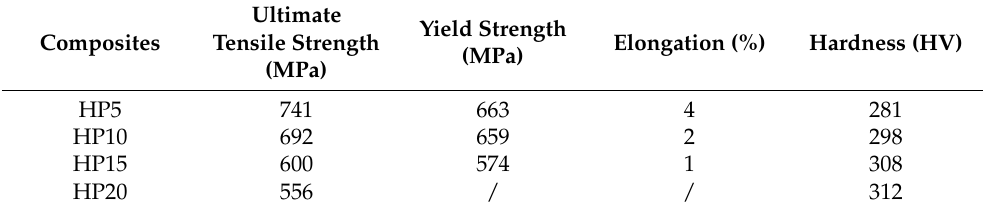
Table 3. Mechanical properties of the Ni-20Cr-Eu 2 O 3